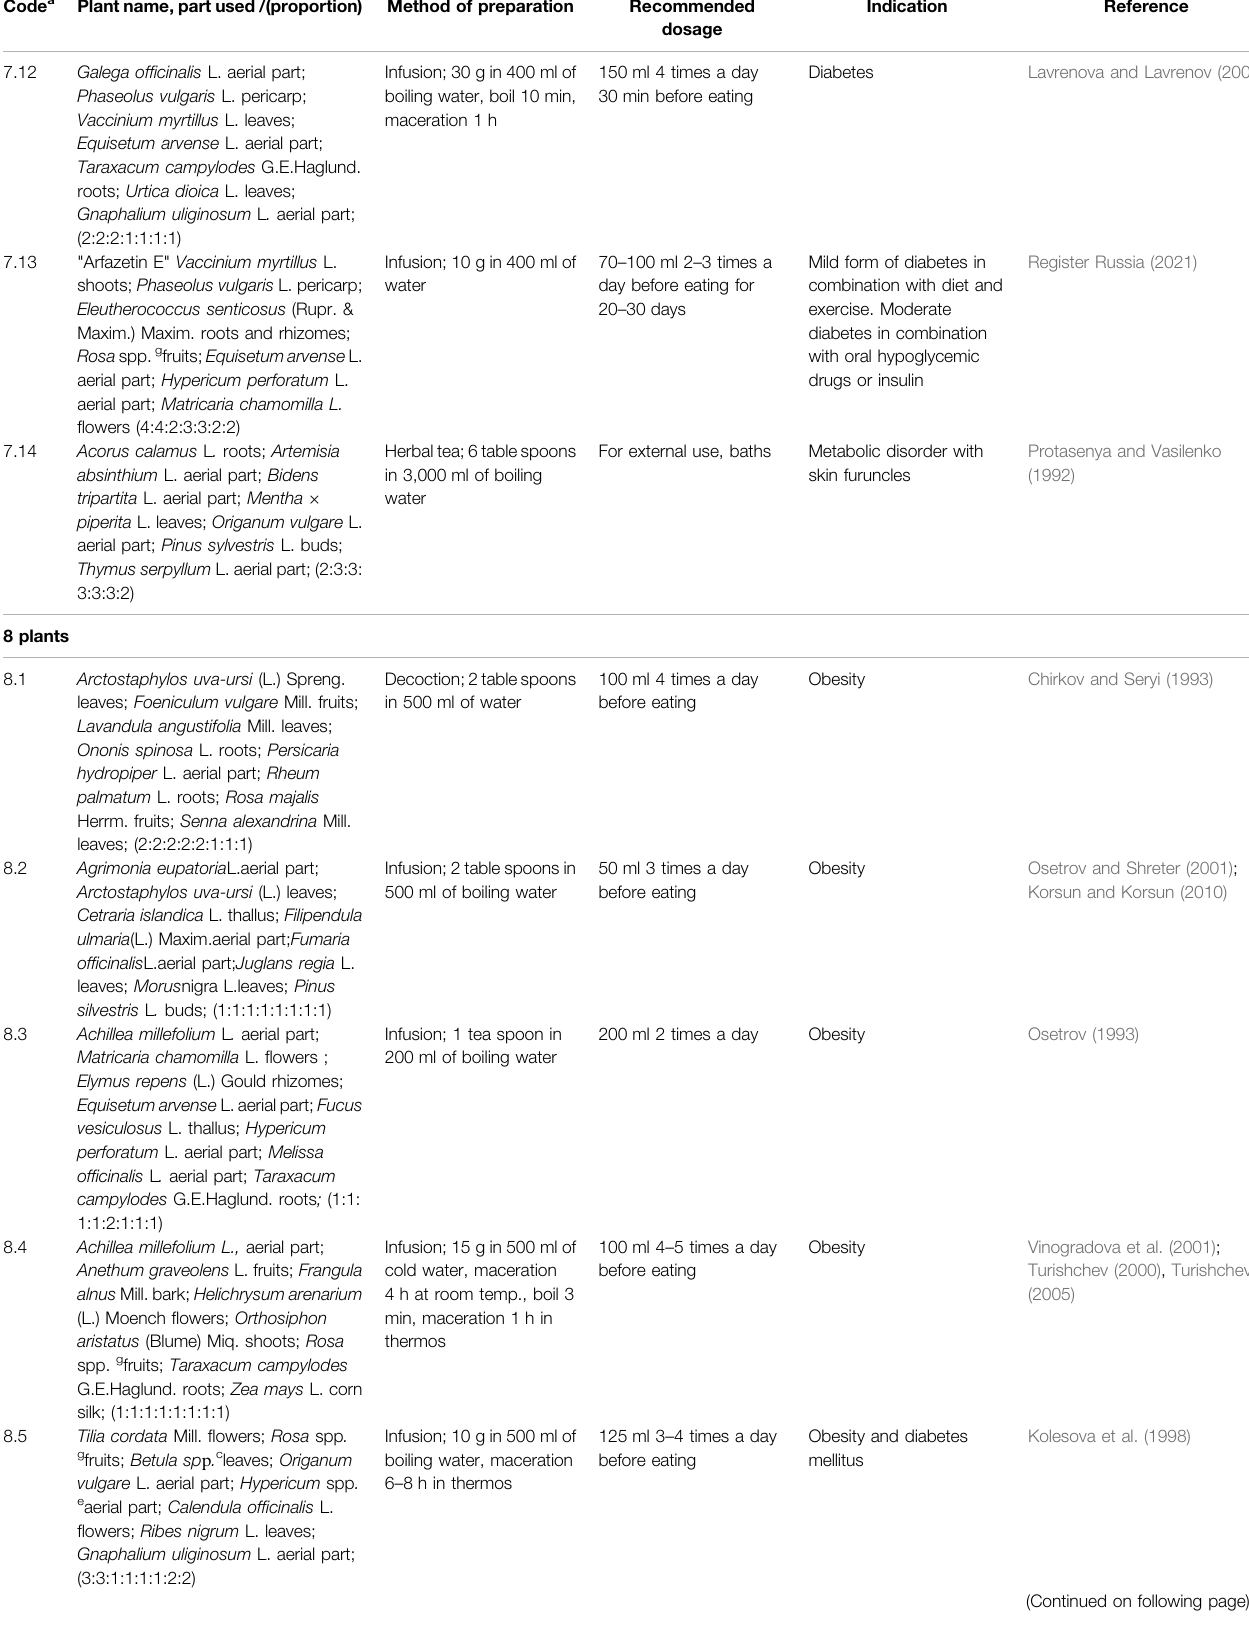
TABLE 1 | ( Continued ) The list of medical species used for the management of diabetes and related disorders in Russia. Code a Plant name, part used /(proportion) Method of preparation Recommended